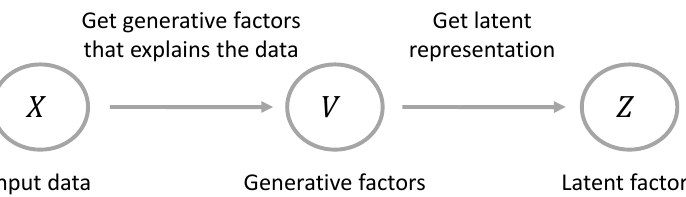
Figure 1. An illustration of the notation used in this paper. For X = { x 1 , x 2 , . . . , x N } , a set of N observations. Disentangled representation learning is expected to identify the distinct generative factors V = { ν 1 , ν 2 . . . , ν n } that explain these observations and encode them with independent latent variables Z = { z 1 , . . . , z n } in latent